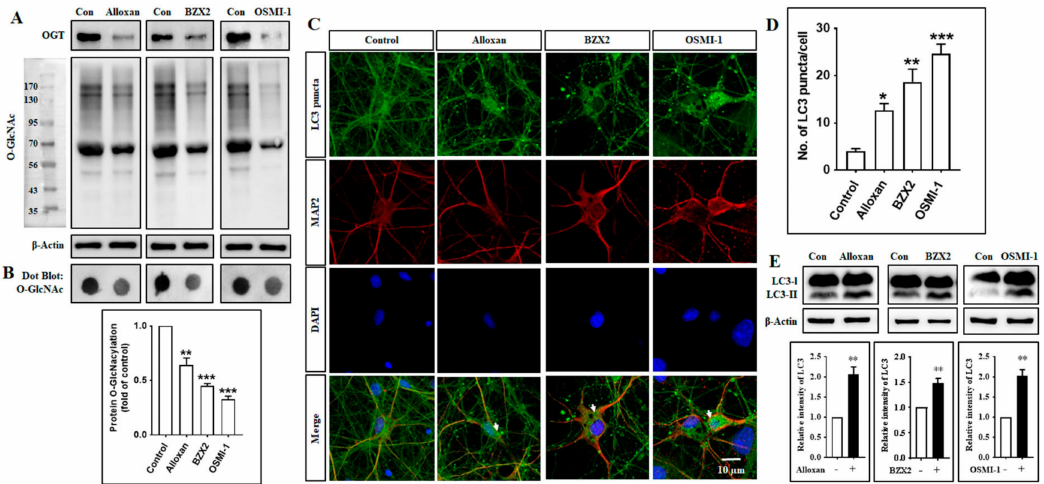
Figure 1. Pharmacological inhibition of O-GlcNAc transferase (OGT) decreases O-GlcNAcylation levels and promotes autophagy in rat cortical neurons. ( A ) Immunoblot analysis of OGT and O-GlcNAcylation levels were determined after treatment of alloxan (5 mM), BZX2 (100 µ M), and OSMI-1 (50 µ M) for 24 h in rat cortical neurons. ( B ) Dot blot analysis of O-GlcNAcylation levels after alloxan, BZX2, and OSMI-1 treatment for 24 h. Densitometry quantification of O-GlcNAcylation protein was performed by Image J. All statistical analysis was obtained as ± SEM ( n = 3, ** p < 0.01, *** p < 0.001). ( C ) Cortical neurons were treated with alloxan, BZX2, and OSMI-1 for 24 h, and the formation of LC3-II puncta was visualized by confocal microscopy following the immunofluorescence staining with anti-LC3 (green) and anti-MAP2, a neuro-specific marker, (red) antibodies. ( D ) LC3-II puncta formation was measured from at least 3 independent random areas from each slide as well as minimum 5 cells which contain puncta was counted and calculated (ns = non-significant, * p < 0.05, ** p < 0.01, *** p < 0.001). ( E ) Immunoblot analysis of LC3 expression levels in rat cortical neurons treated with alloxan, BZX2 or OSMI-1. Densitometry quantification of LC3 levels was performed using Image J. All data are presented as mean ± SEM ( n = 3, ** p <